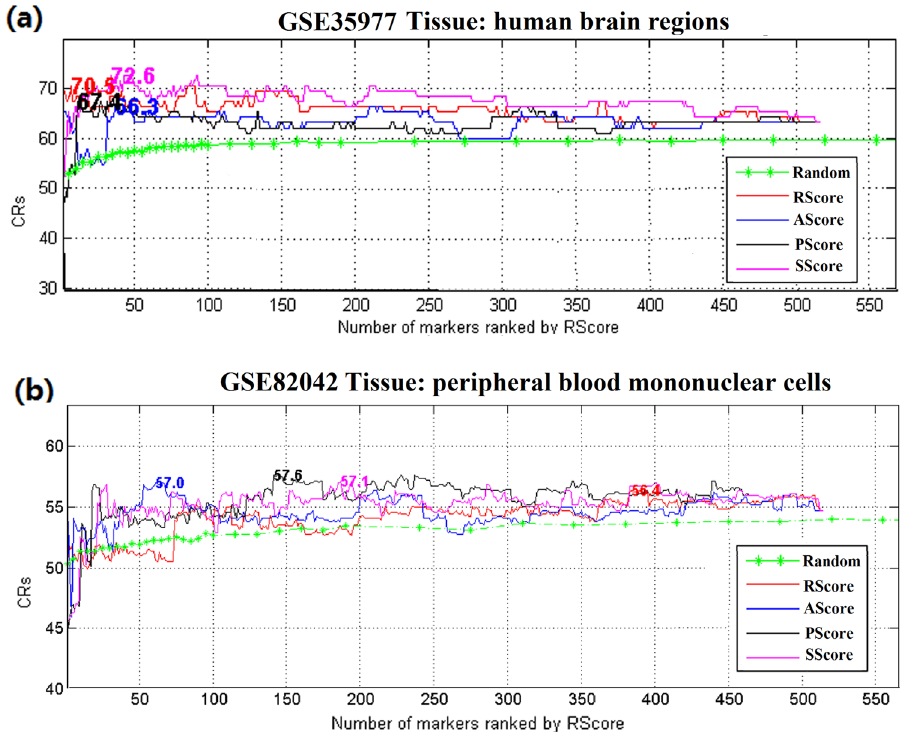
Figure 2. Validation of different metrics through a LOO cross-validation. ( a ) Results from GSE35977. ( b ) Results from GSE82042. Mean CRs of randomly selected genes are displayed in green. The maximum CRs for each metric are presented in corresponding